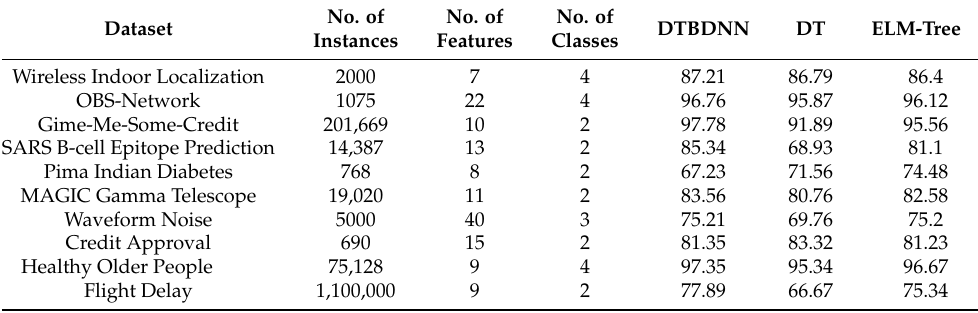
Table 3. Testing accuracies of DTBDNN and decision tree (C4.5 algorithm) and ELM-Tree models.